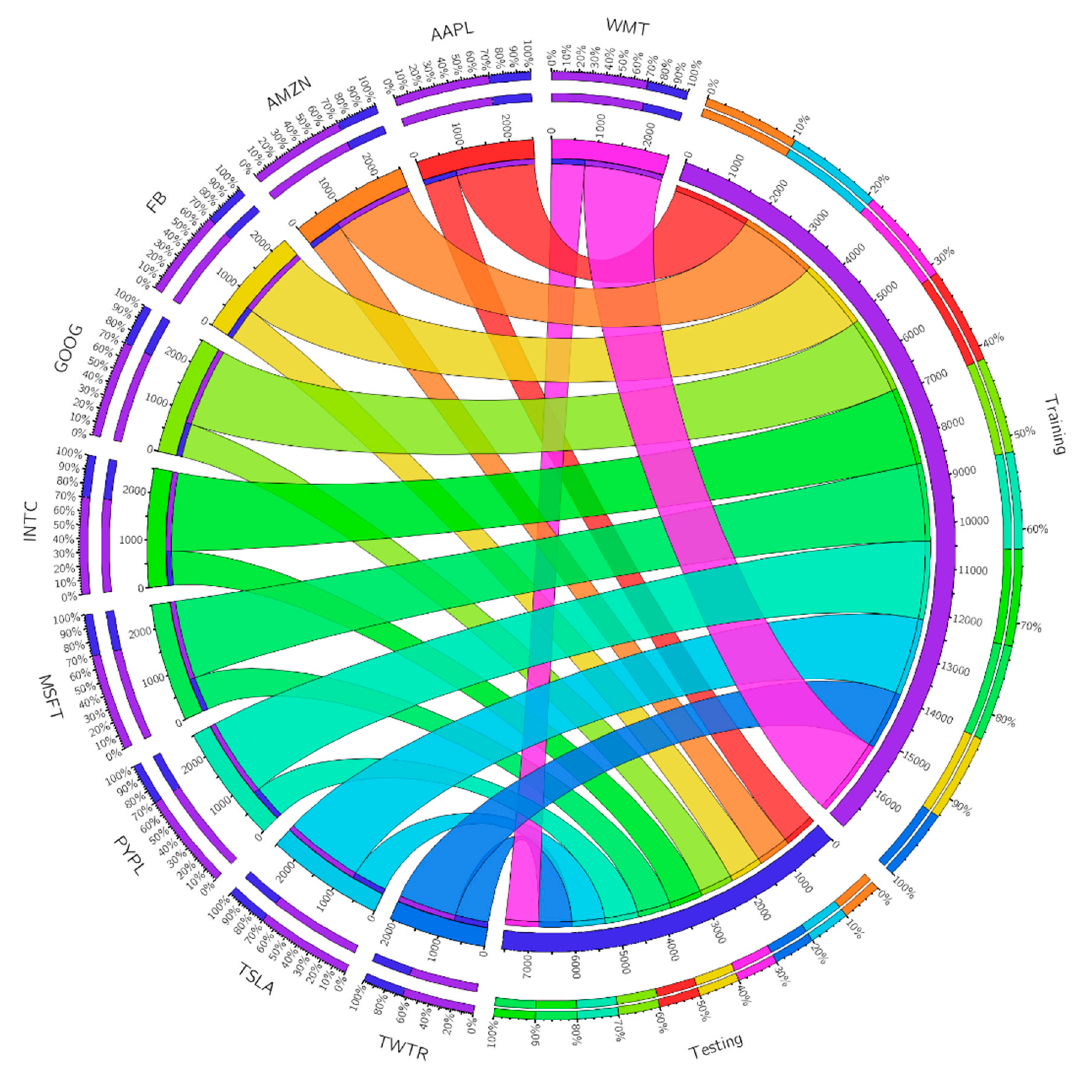
Figure 3. A visualization of dataset